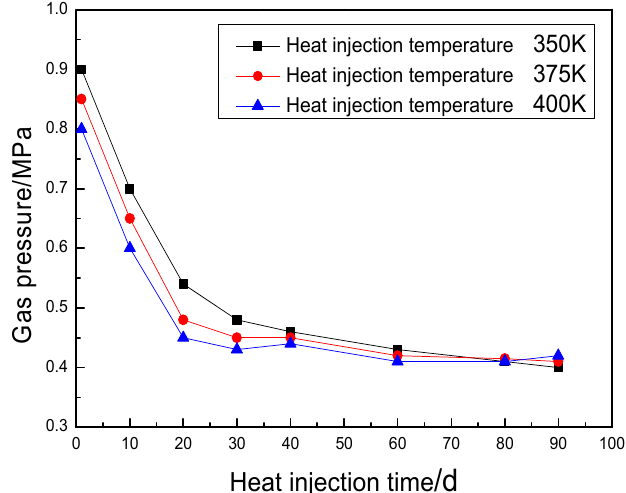
Figure 8. The variation curve of gas pressure with the drainage time at 1 m away from the borehole.